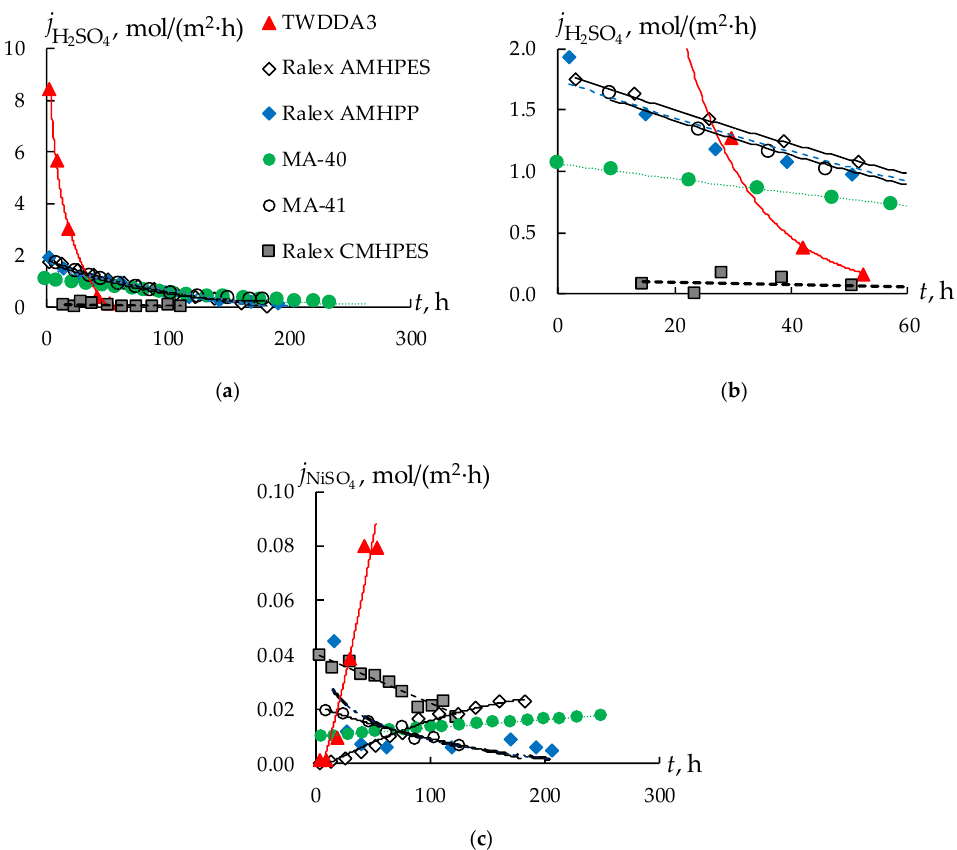
Figure 3. Kinetic dependence of the sulfuric acid fluxes ( a ), the initial section of this dependence ( b ) and nickel sulfate fluxes ( c ) for membranes during DD. The data caption on all figures corresponds to the caption given in ( a ).